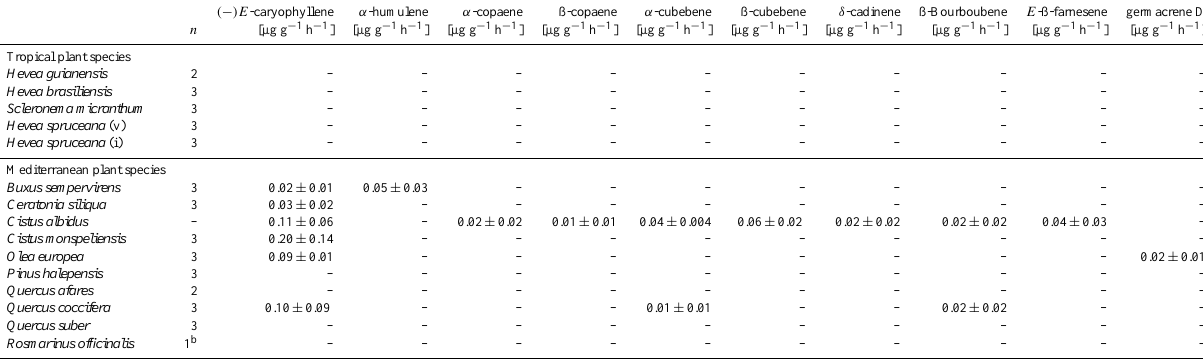
Table 6. Sesquiterpene species emitted a from Mediterranean and tropical plant species measured with GC-FID. Averages ± standard errors are calculated from n number of replicates. All averages ± standard errors are calculated from < 100 samples (tropical) or 18–83 samples (Mediterranean) from n tree